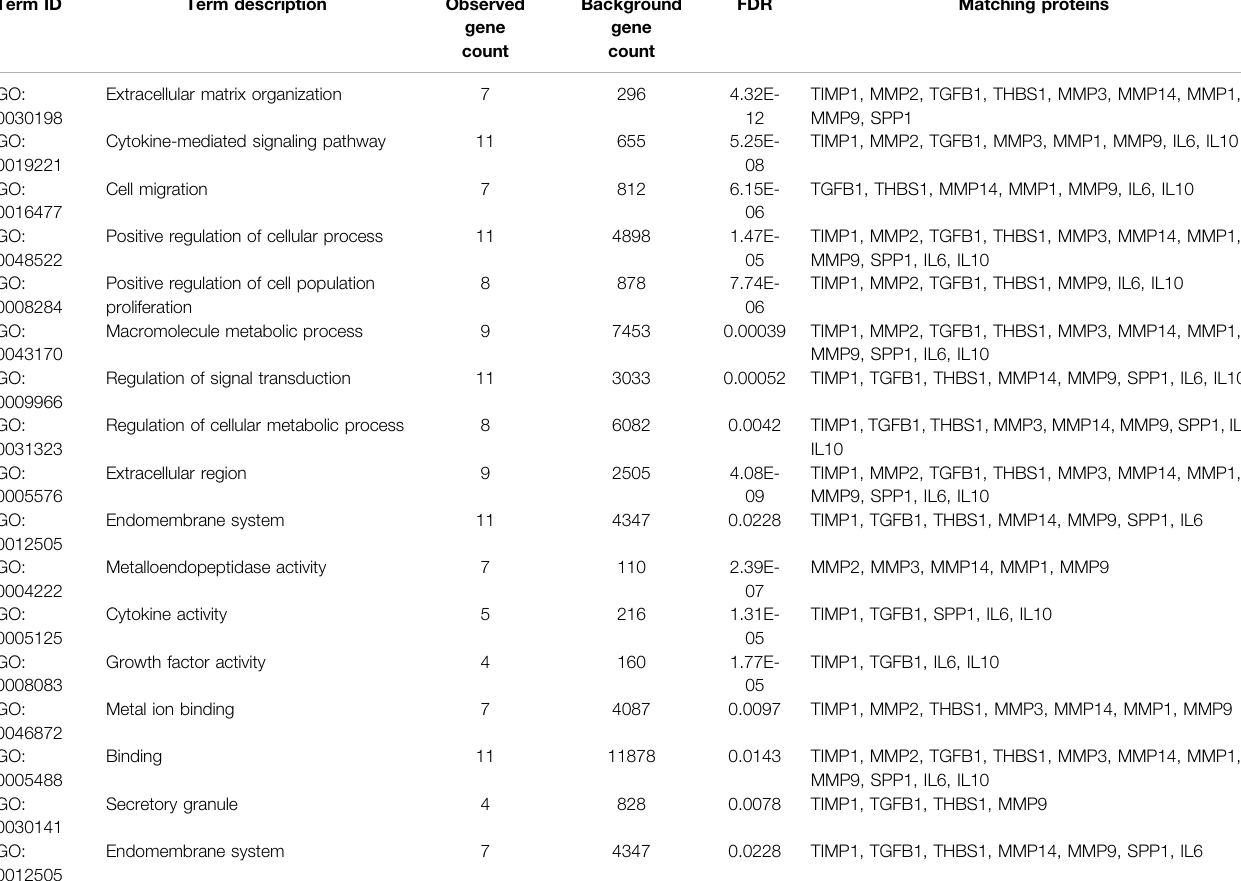
TABLE 5 | GO enrichment of TIMP1 retrieved from the STRING database.